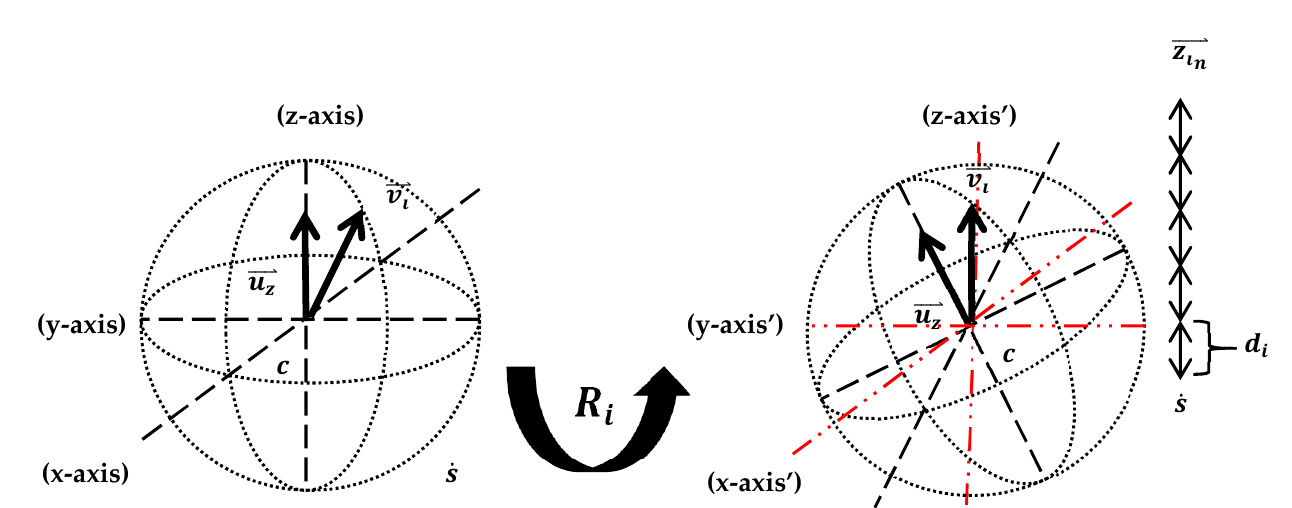
Figure 8. Axis realignment and planar elevations calculations.